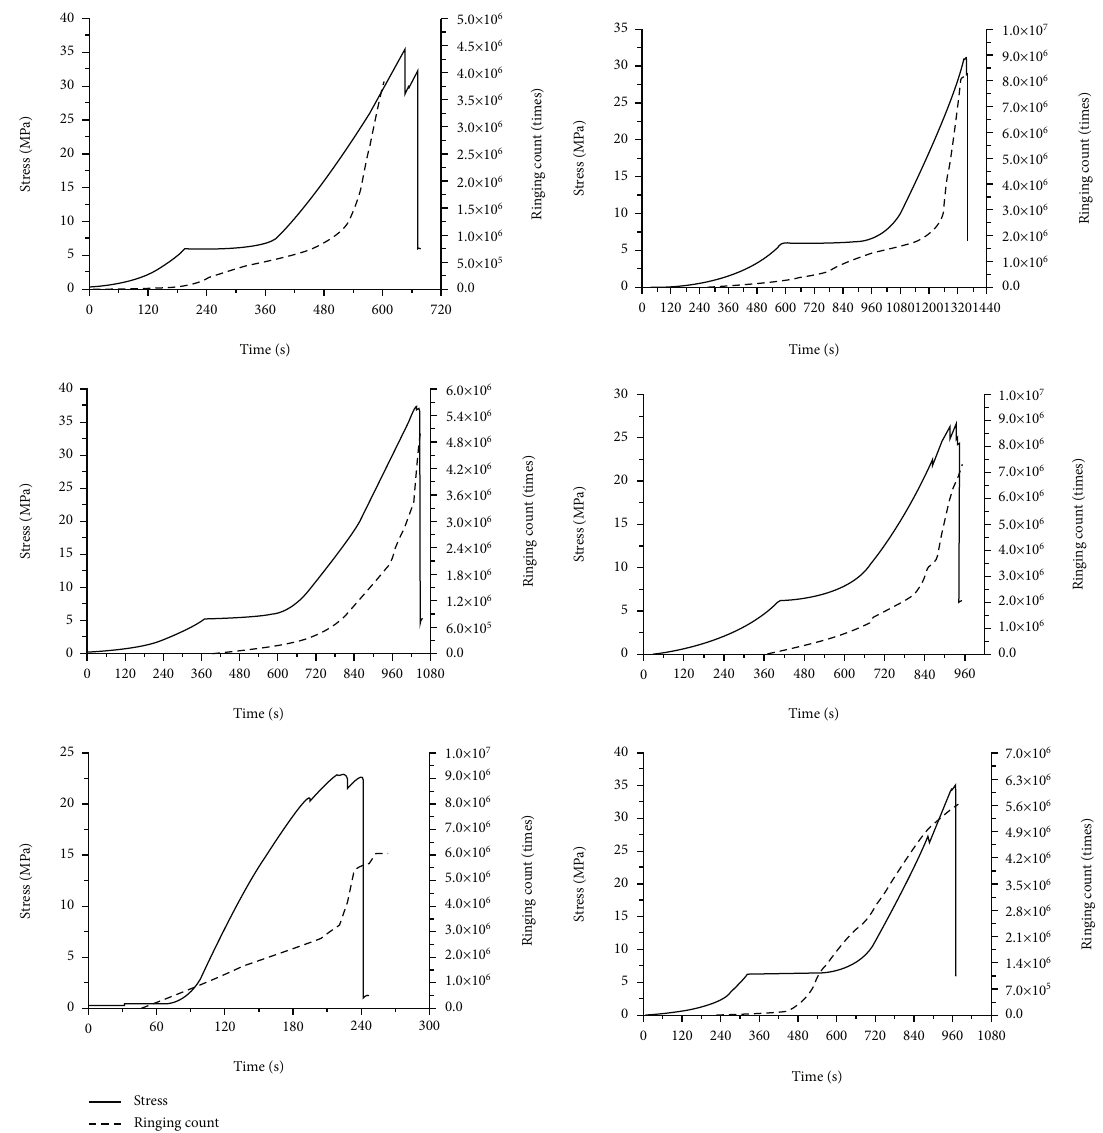
Figure 9: AE count results of specimens